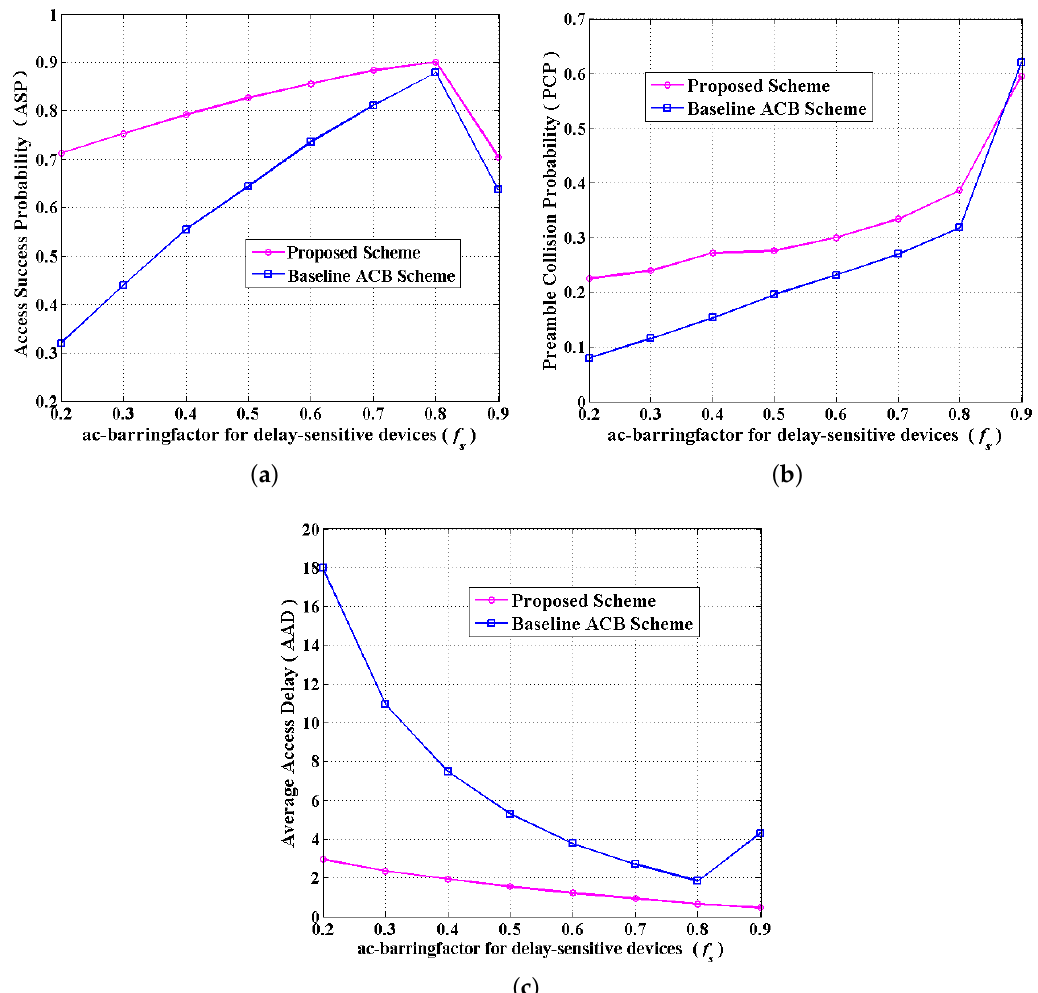
Figure 8. Performance comparison between the proposed scheme and the baseline access class barring (ACB) scheme. ( a ) The ASP versus the ac_barringfactor of the cluster for delay-sensitive devices; ( b ) the preamble collision probability (PCP) versus the ac_barringfactor of the cluster for delay-sensitive devices; ( c ) the AAD versus the ac_barringfactor of the cluster for delay-sensitive